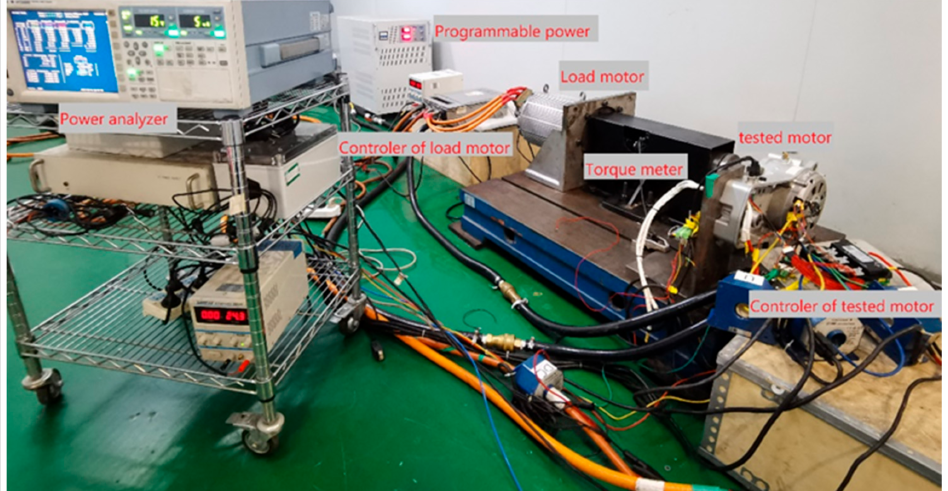
Figure 10. Experimental platform of PMSM drive